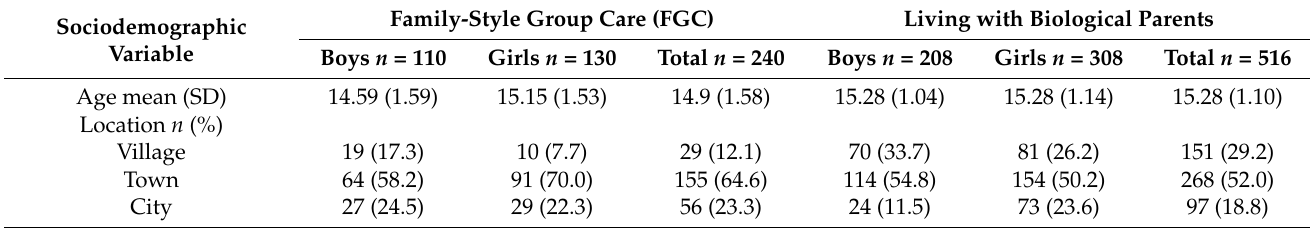
Table 1. Demographic characteristics of the two samples.